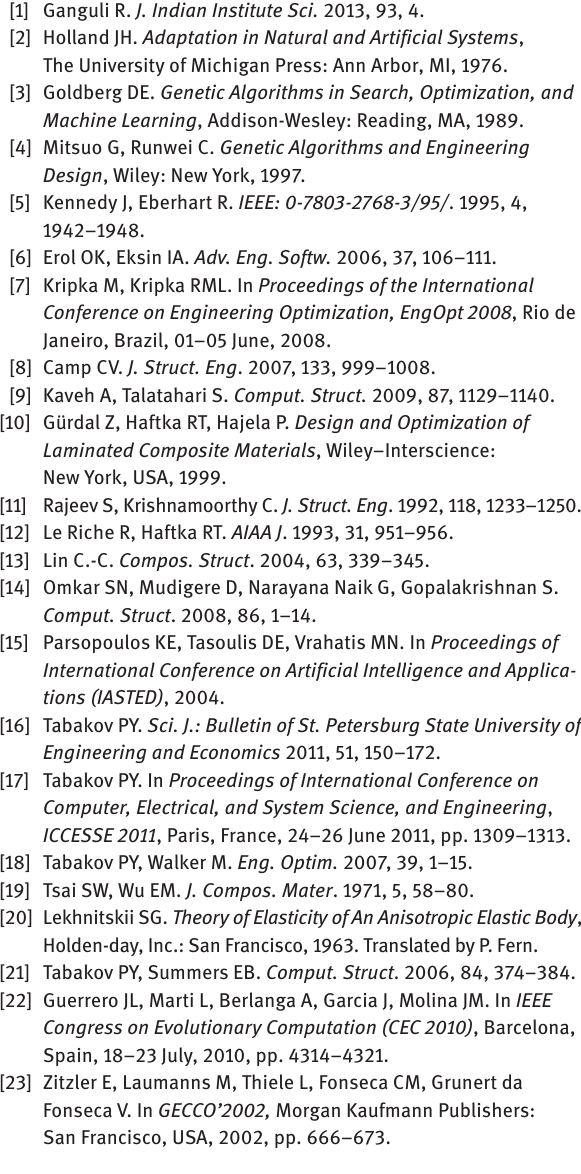
Figure 9: Effect of manufacturing tolerances on the burst pressure of the two-layered pressure